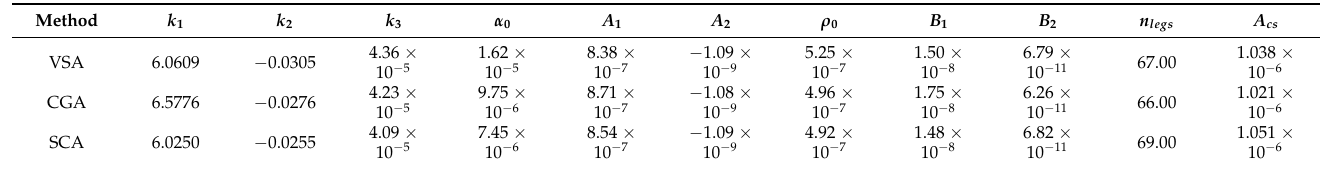
Table 2. Parameters obtained by the best solution (minimum RMS error).